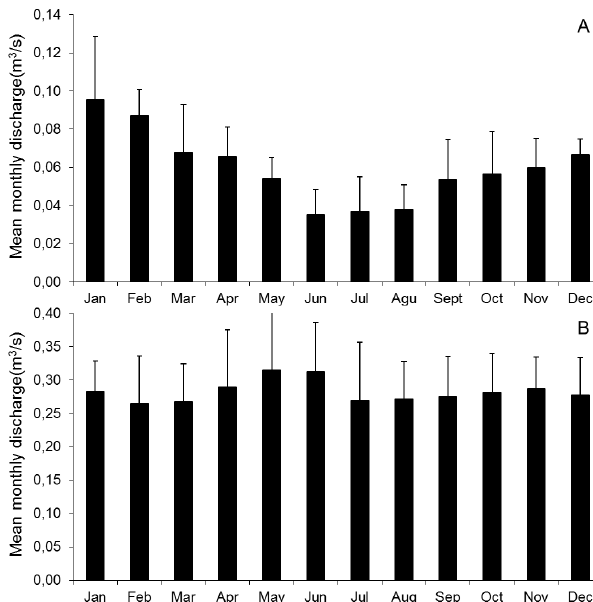
Fig. 3. Mean monthly discharge data at two gauging stations with high ( A , Los Crespos station, 54.5% of glacier cover in the catch- ment) and low glacial influence ( B , Humboldt station, 8.6% of glacier cover in the catchment) over 1yr in the Antisana volcano catchment, Ecuador. Mean values and standard deviations for (A) and (B) were calculated over 5 (2006–2010) and 11yr (2000–2010),